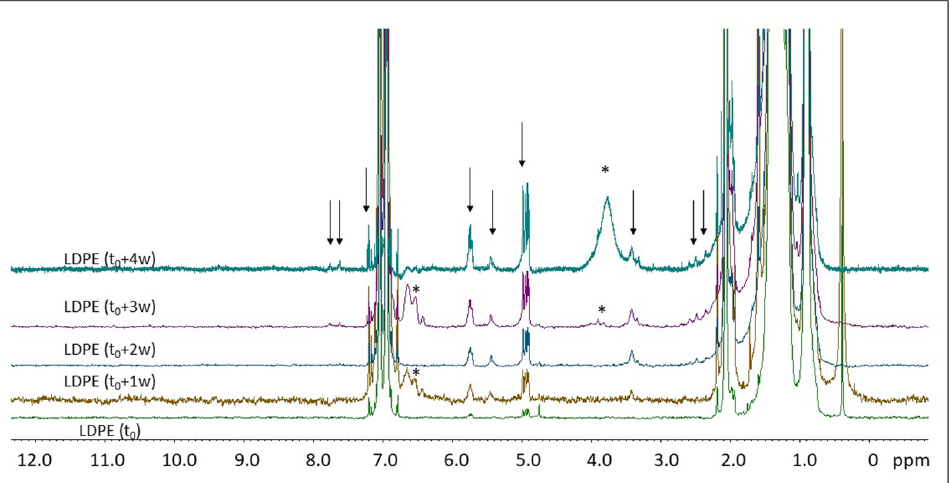
Figure 7. Stackplot of the 1 H NMR spectra of the LDPE microplastics at different times of irradiation (from bottom to top): t 0 , t 0 + 1 w, t 0 + 2 w, t 0 + 3 w, and t 0 + 4 w, enlarged at the spectral baseline in the whole proton spectral region. Spectra were normalized with respect to the aliphatic signal centered at 1.3 ppm, due to the CH 2 moiety of the LDPE chain. Dark arrows indicate the most significant signals appearing as a result of degradation, while asterisks (*) show anomalous signals in some of the analyzed